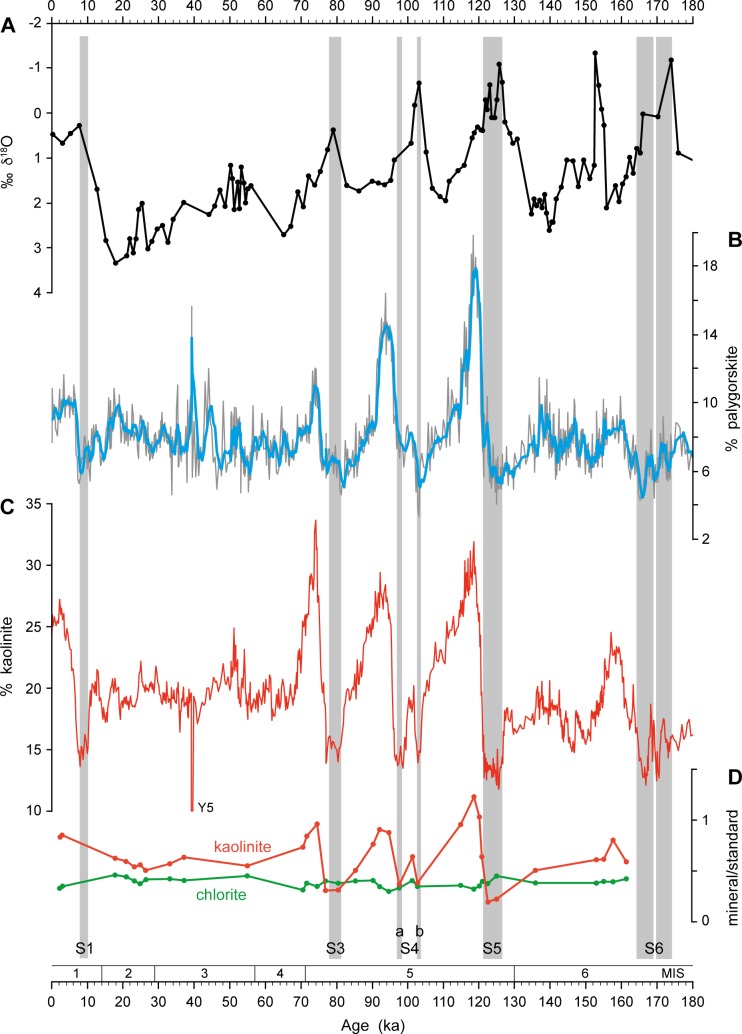
Additional data for sediment core M40/4_SL71.(A) Oxygen isotope record (data from [50]). (B) Concentration of palygorskite within the clay mineral assemblage, including 5-point running average. (C) Concentration of kaolinite within the clay mineral assemblage. Grey bars indicate sapropel layers. (D) Ratios of kaolinite/standard (red) and chlorite/standard (green).